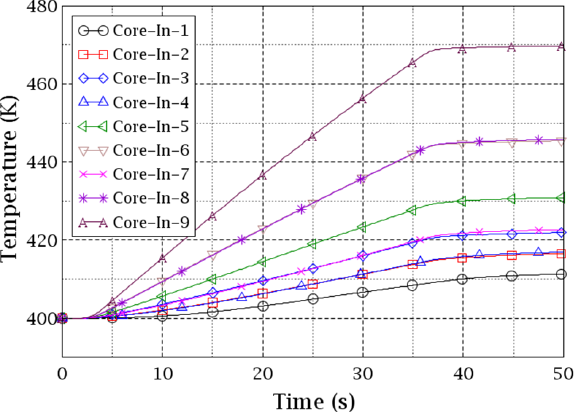
Figure 14. Evolution of the coolant temperature distribution at the core inlet CA-V (cell index is from Figure 10).